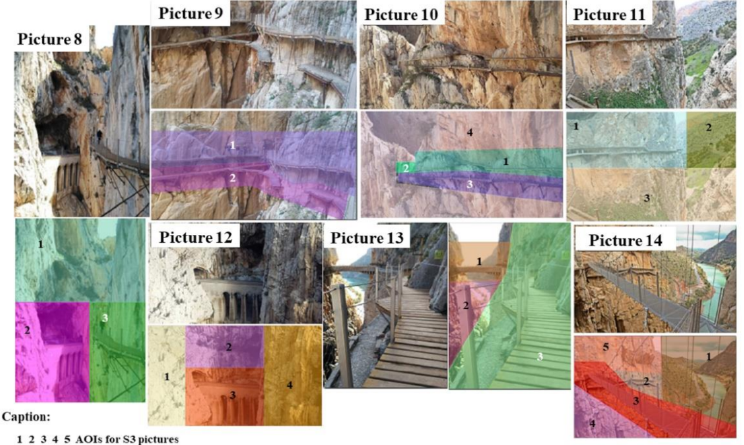
Figure 6. AI images for zone